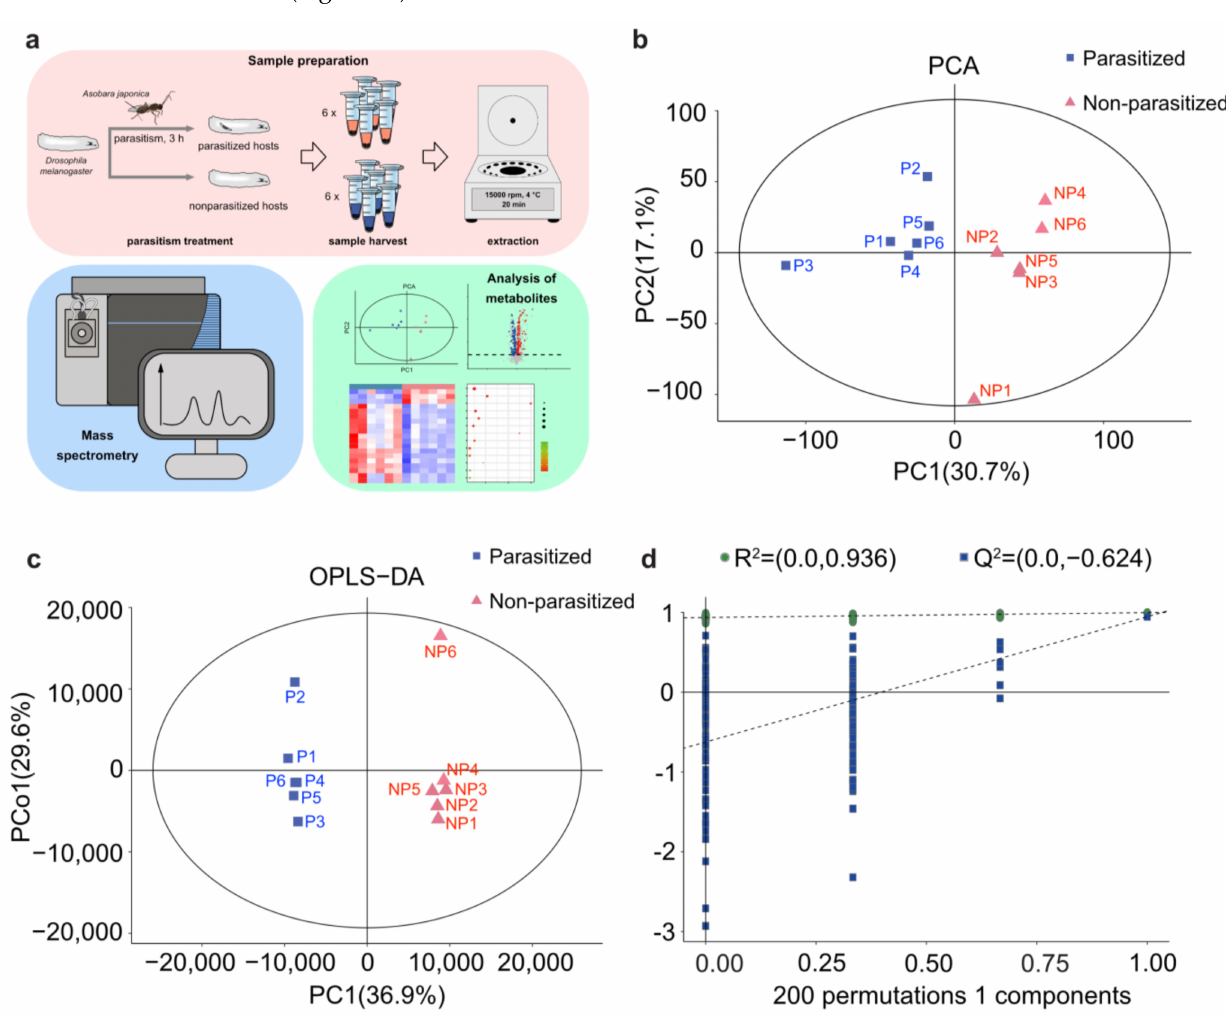
Figure 1. PCA and OPLS-DA analyses of metabolic differences. ( a ) Workflow for metabolomics analysis. ( b ) Principal component (PC) analysis (PCA) score plot of the metabolite profiles of D. melanogaster larvae in the parasitized group and non-parasitized group. Data points are displayed as sample projections on the two primary axes. The oval represents the 95% confidence interval of the model using Hotelling’s T2 statistics. Variances explained by the first two components (PC1 and PC2) are shown in parentheses. ( c ) Orthogonal partial least-squares discriminant analysis (OPLS-DA) score plot shows a clear separation of metabolic profiles between the parasitized and non-parasitized D. melanogaster larvae. Variances explained by the principal components (PC1 and PCo1) are shown in parentheses. Abbreviations: PC1, predictive component 1; PCo1, predictive component orthogonal 1; NP, non-parasitized host; P, parasitized host. ( d ) Permutation tests of OPLS-DA models. The permutation test was carried out with 200 random permutations, and the resulting R 2 and Q 2 values were plotted. Green circle, R 2 ; Blue square, Q 2